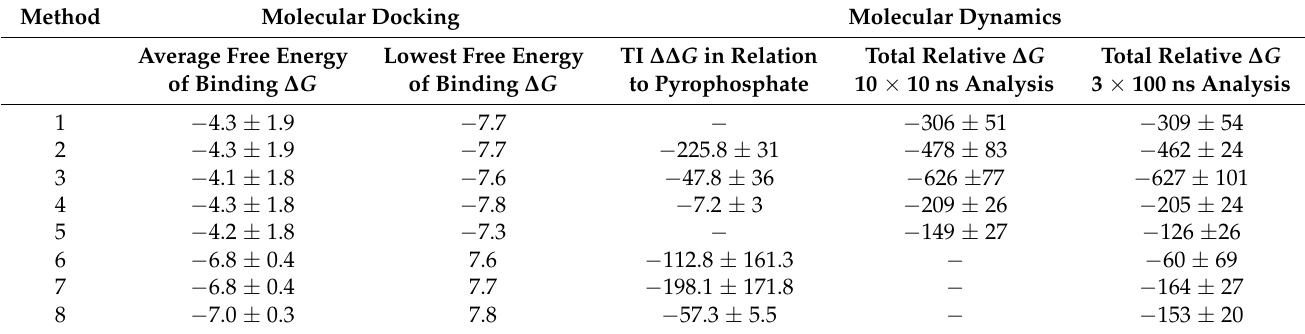
Table 1. Binding affinities of selected ligands toward TNAP. All ∆ G and ∆∆ G values are in [kcal/mol].